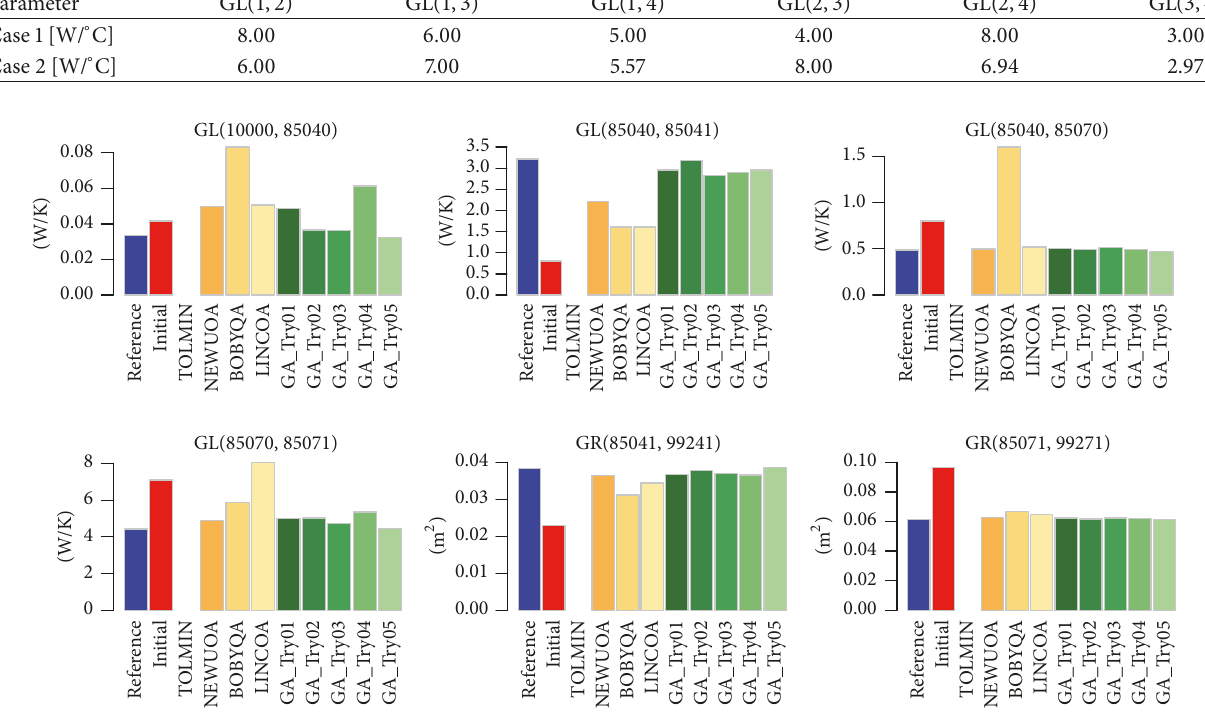
Figure 11: Transient. Variable values obtained from correlations.